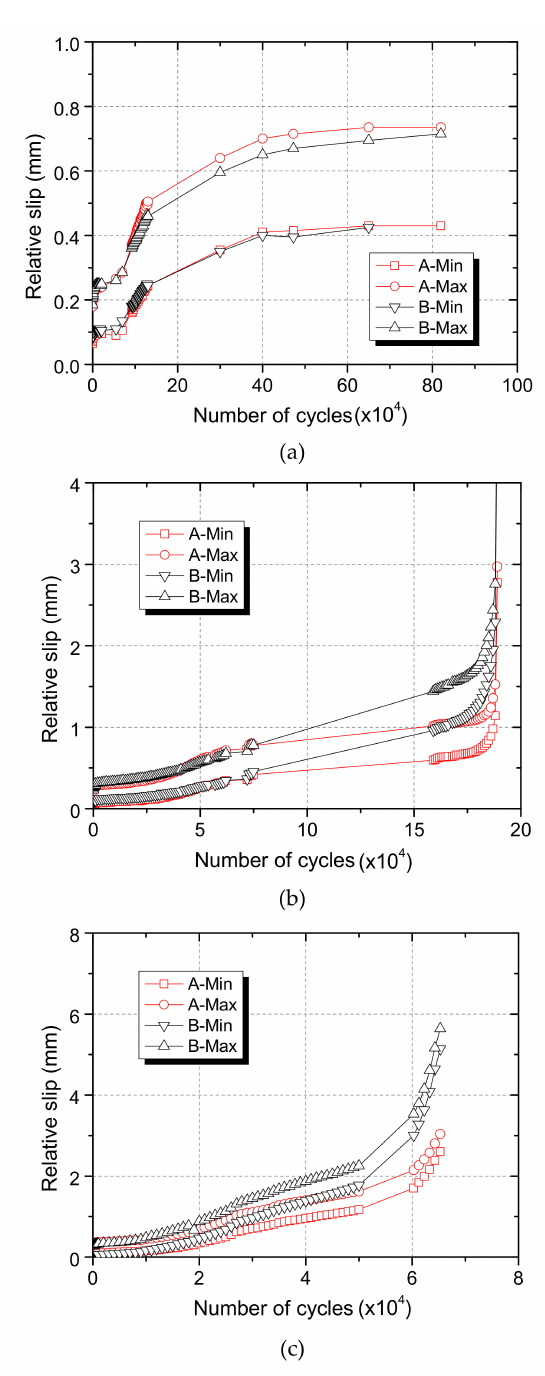
Figure 19. Dynamic relative slip: ( a ) RS25-50-U; ( b ) RS25-70-U; ( c )